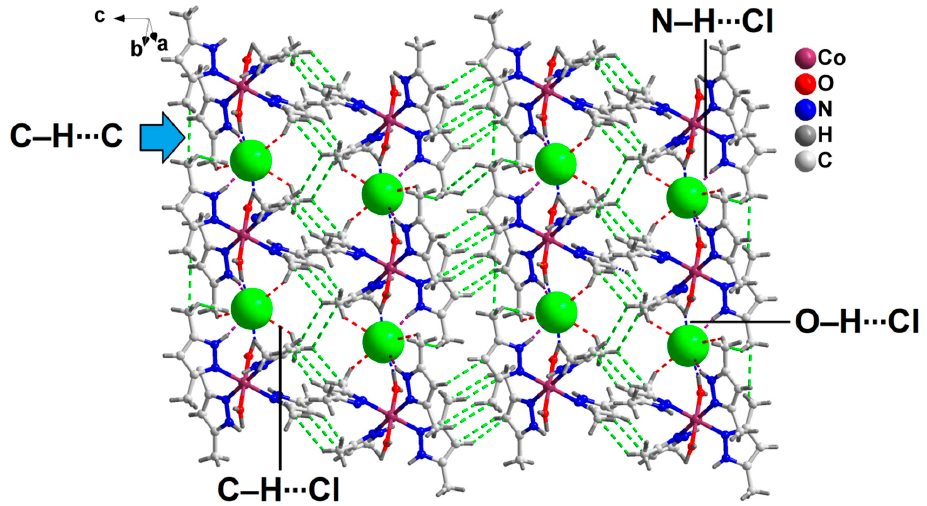
Figure 8. Layered assembly of compound 2 along the crystallographic bc plane assisted by the en- clathrated chlorine atoms. Table 3. Selected hydrogen bond distances (Å) and angles (deg.) for compounds 1 and 2